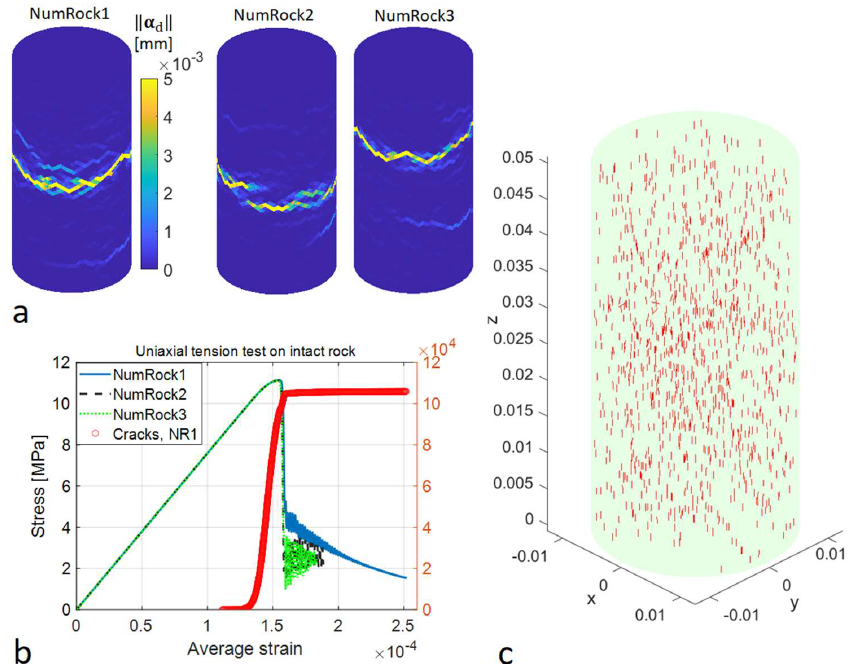
Figure 5. Simulation results for uniaxial tension test (intact rock): ( a ) Crack opening magnitudes for all numerical rocks; ( b ) Average stress-strain curves for all numerical rocks and cumulative crack number for NumRock1; ( c ) Crack normals with NumRock1 (every 100th plotted).